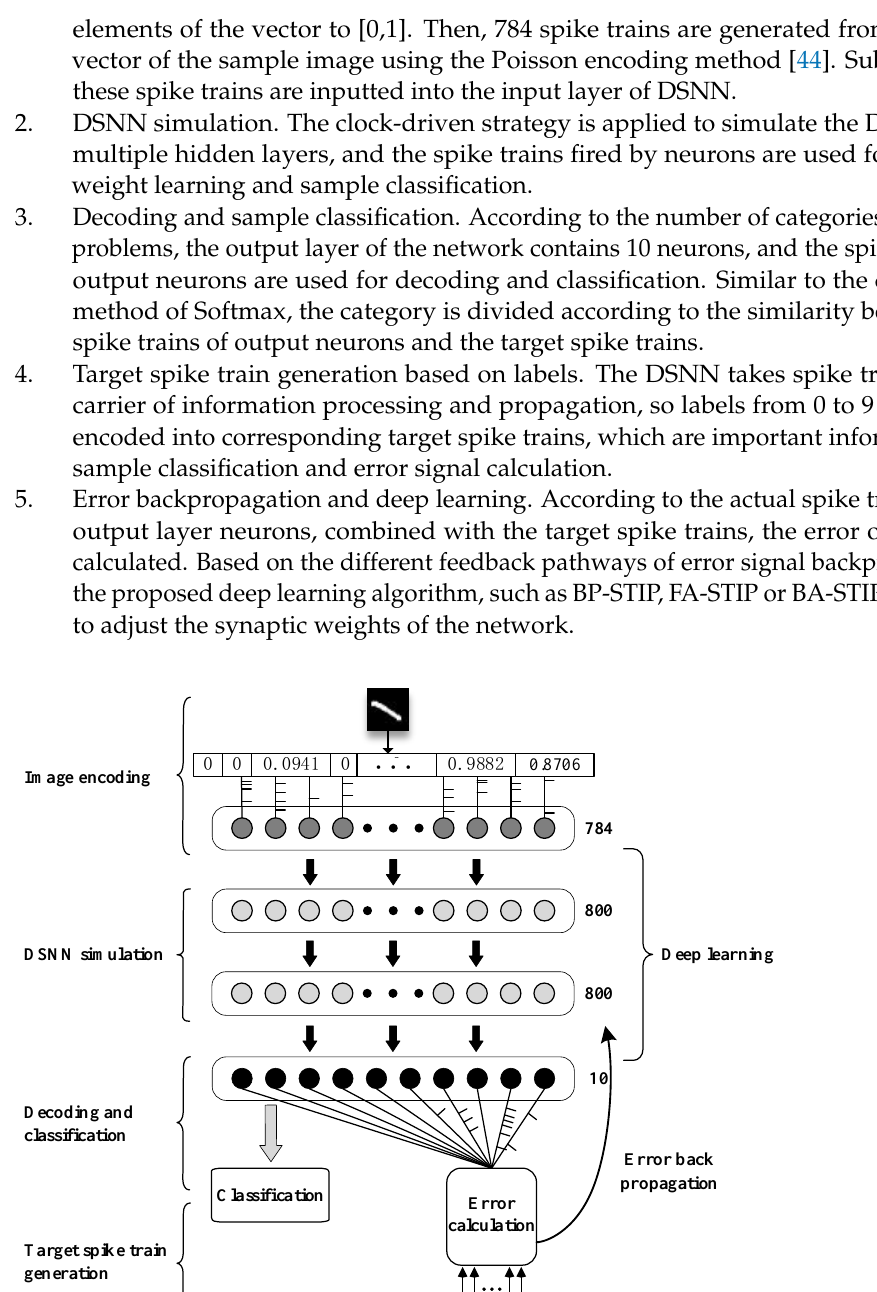
Figure 3. Target spike train generation process using image labels. In this paper, a four-layer feedforward network is used in the image classification, which includes an input layer composed of 784 neurons, two hidden layers, and an output layer composed of 10 neurons. A LIF neuron model is chosen as the basic computing unit, the parameters of all LIF neurons in the network are set as follows: the time decay constant of postsynaptic potential is 5.0 ms, the threshold of spike firing is 5.0, and the resting and reset potential is set to 0. Additionally, the simulation interval of the network is set to 10 ms, and the initial matrices W of synaptic weights as well as the feedback matrices B and